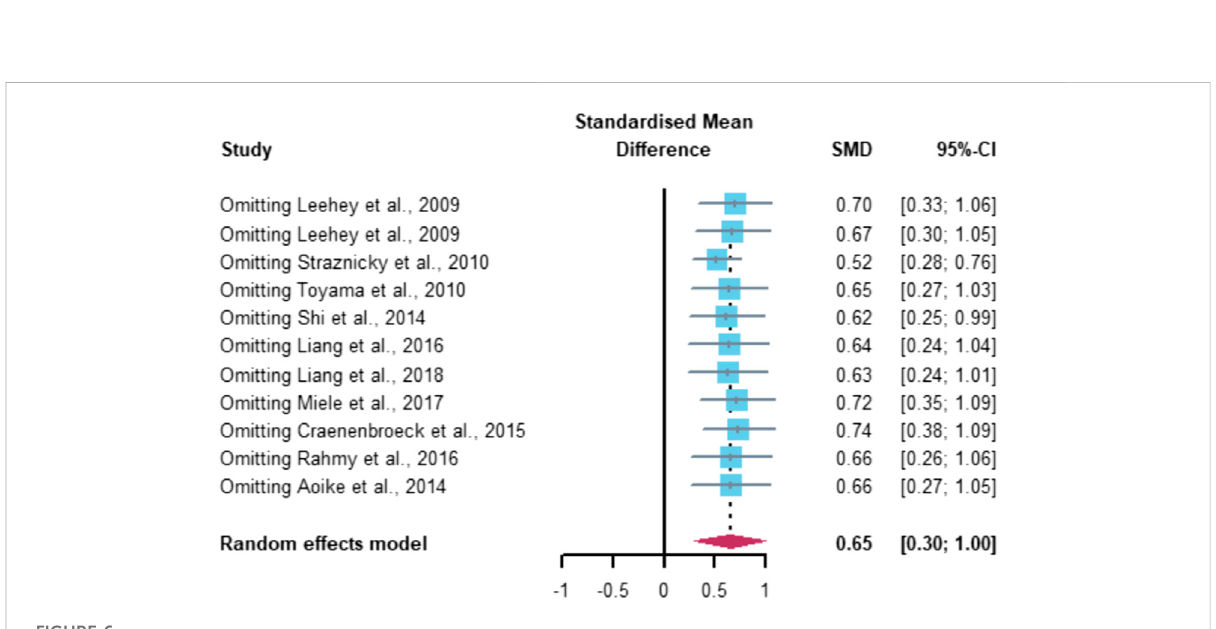
Sensitivity analysis of aerobic exercise affecting